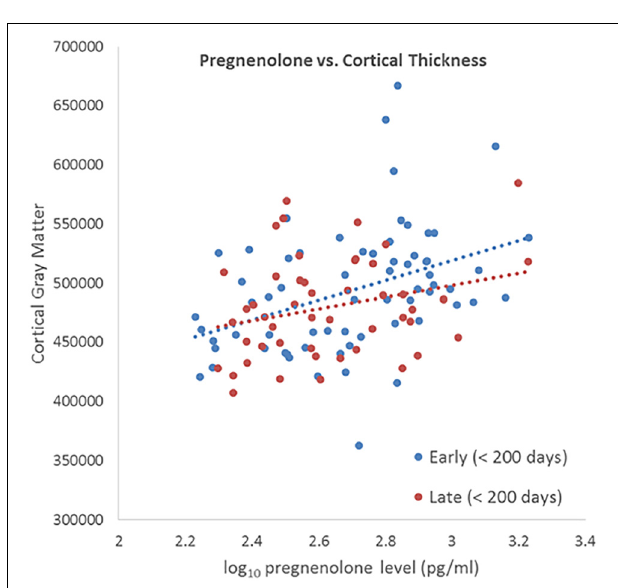
FIGURE 5 | Scatter plot of log10 transformed pregnenolone levels ( x -axis) against cortical thickness ( y -axis) separately for the early (blue dots/line) and late subgroups (red dots/line). Fisher’s r -to- z showed no significant difference between early ( < 200) and late ( > 200) correlations (Z = 0.673, p =